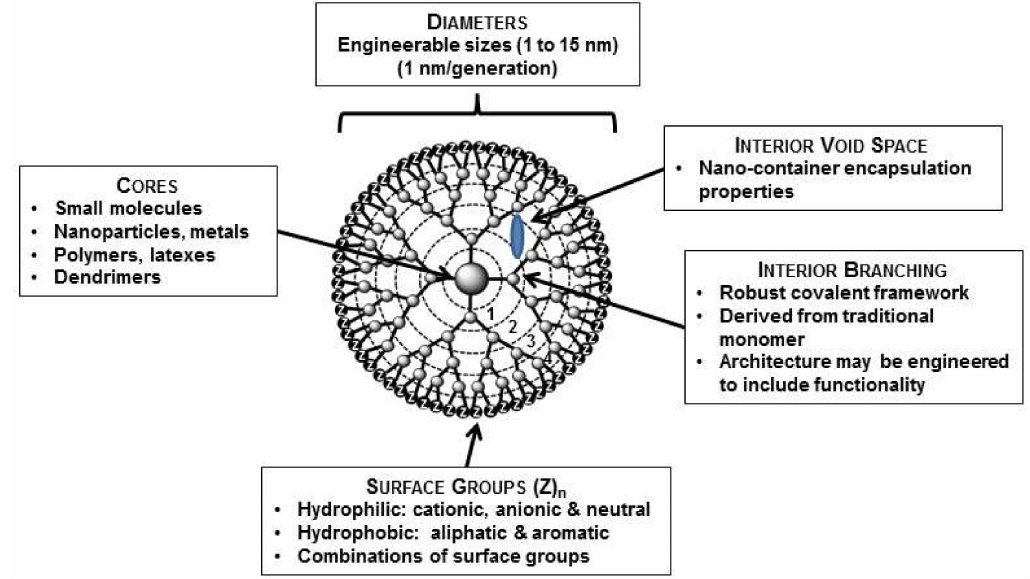
Figure 1. Schematic presentation of a G4 dendrimer containing four generations. Reproduced with permission